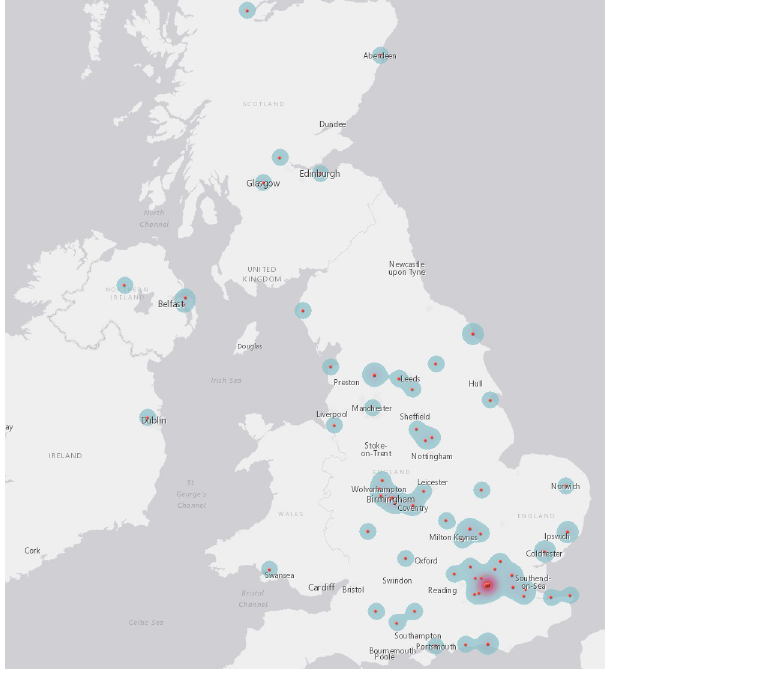
Fig 2. UK and Ireland campaigner